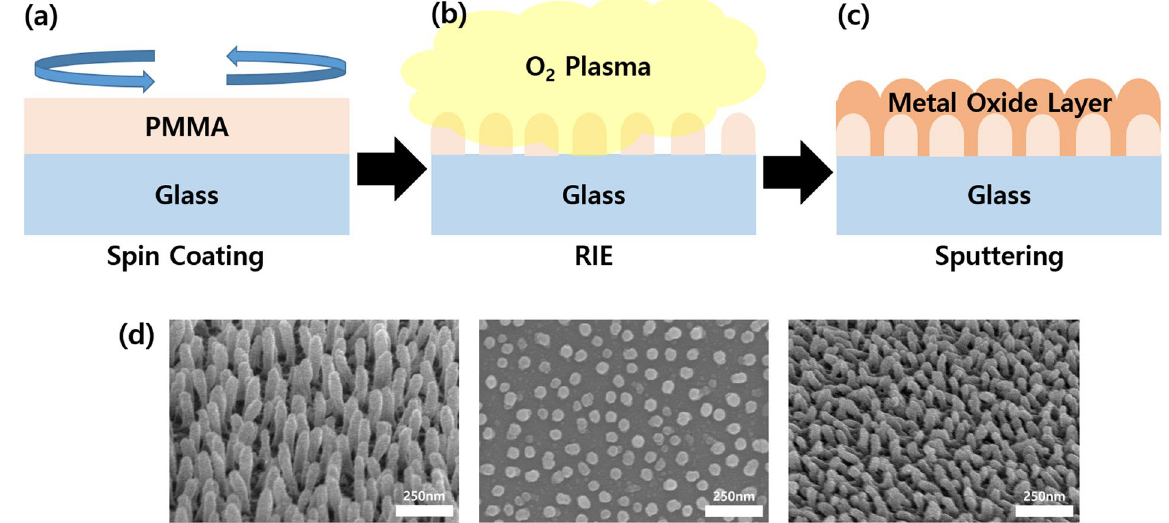
Figure 1. Fabrication process of diffusion layer: ( a ) PMMA spin coated on the substrate, ( b ) etching the PMMA by reactive ion etching (RIE) O 2 plasma, and ( c ) deposition of the refractive matching layer. ( d ) FE-SEM images of the diffusion layer (left: tilted PMMA nanostructure, middle: plane PMMA nanostructure, right: diffusion